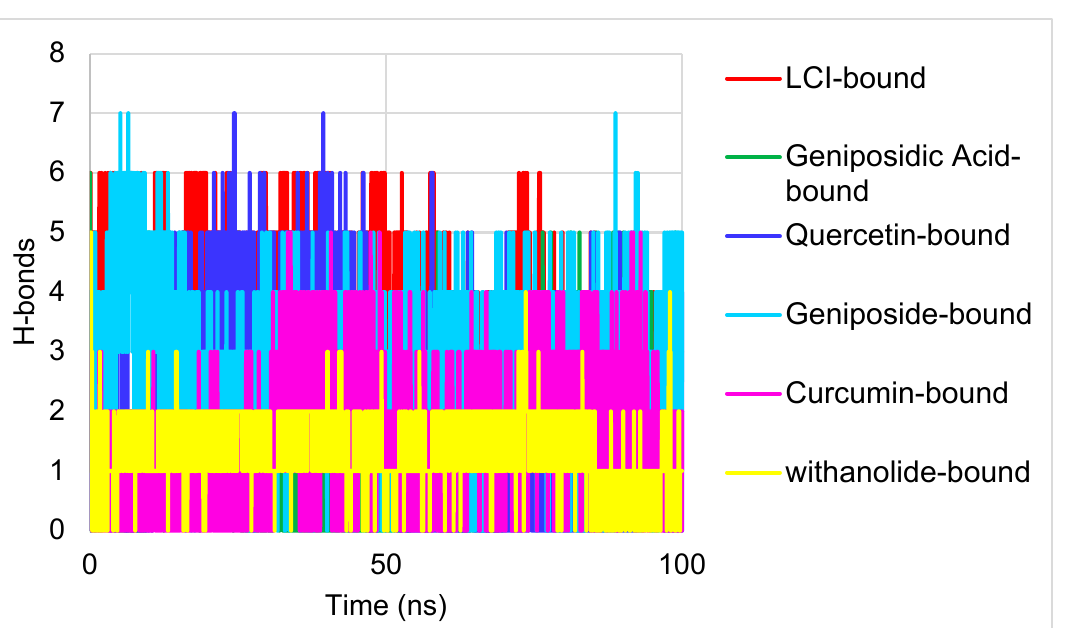
Figure 6. Number of H-bonds during 100 ns MD simulations. LCI was shown to have the most sumptuous moderate hydrogen bond count (3.51), followed by geniposide (2.57 hydrogen bonds) and curcumin (1.5 hydrogen bonds).